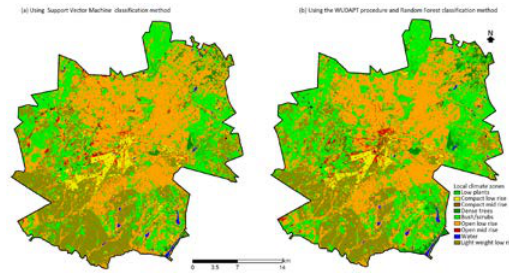
Figure 2: Local climate zones map for Harare metropolitan city obtained using (a) SVM classifier and (b) WUDAPT method (Random Forest